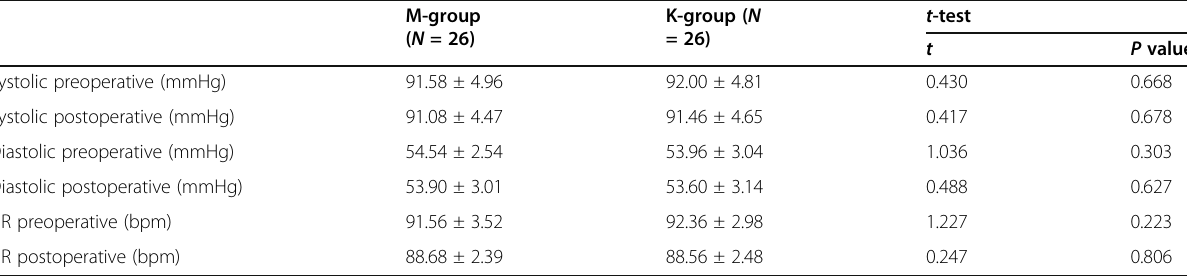
Table 3 Vital data